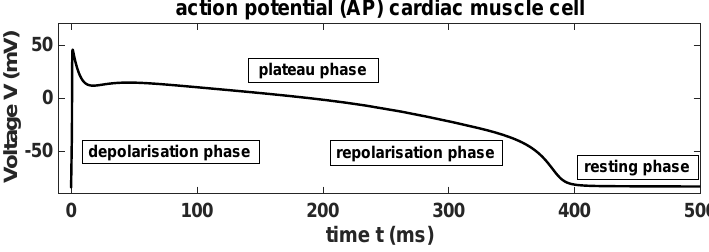
Figure 1. One example of a normal characteristic action potential (AP) of a cardiac muscle cell.